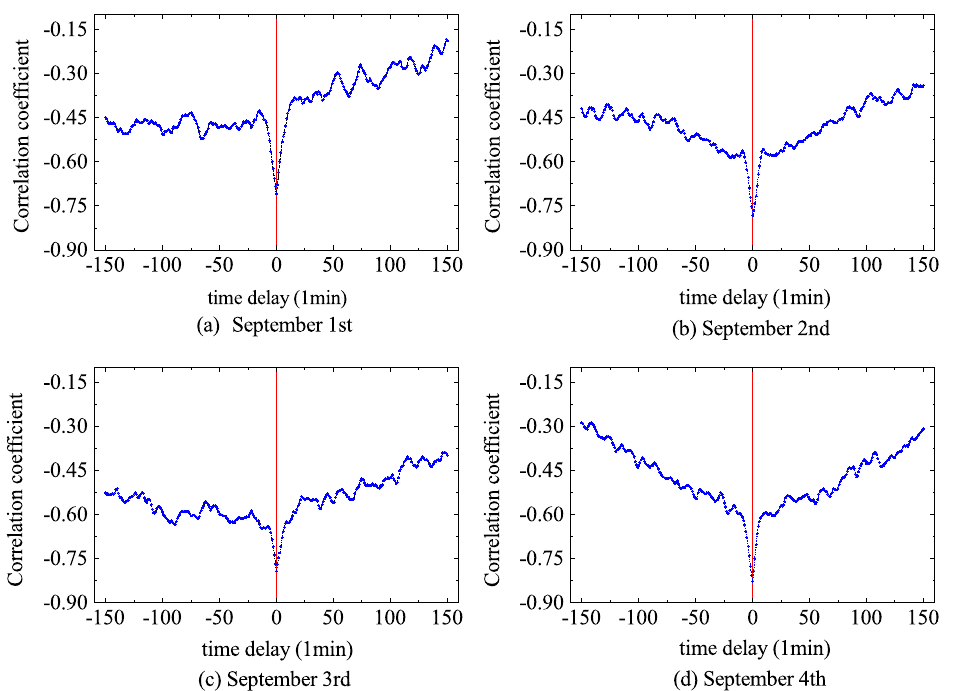
Figure 15. Values of Correlation coefficient with time